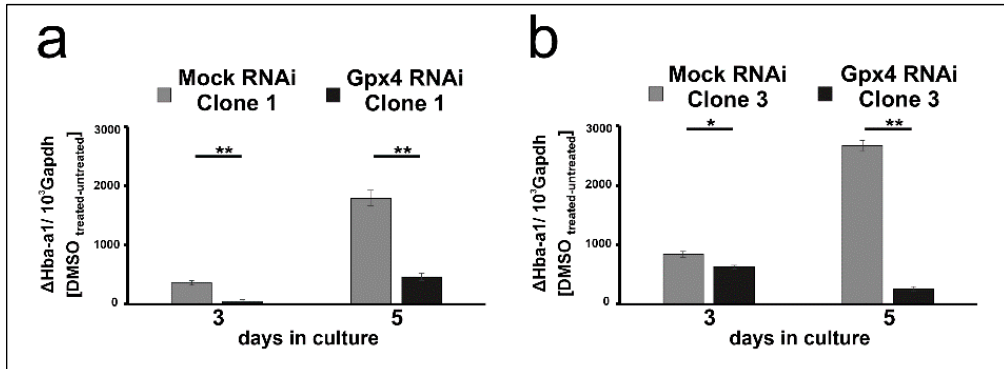
Figure 5. Delay of DMSO-induced erythroid differentiation in two additional clones of Gpx4 deficient MEL cells. MEL cells, stably transfected with a Gpx4 siRNA plasmid (Gpx4 RNAi) or with a corresponding control vector (MOCK RNAi) were seeded in culture dishes (10 4 cells/mL) and cultured at 37 °C for 5 days without or with 2% DMSO (see Material and Methods). Total RNA was extracted from untreated and DMSO-treated MEL cell transfectants at different days of culturing period. The steady-state concentrations of Hba-a1mRNA and Gapdh mRNA were quantified by qRT-PCR using specific amplification primers. ( a , b ) Different individual stably transfected RNAi MEL cell clones. Significances were calculated using the Student’s t -test, * p < 0.05, ** p < 0.005.